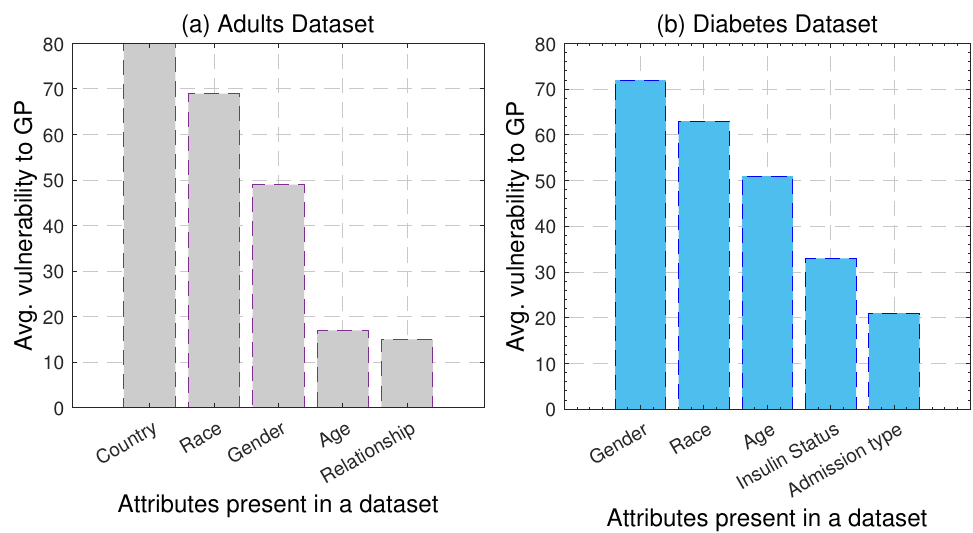
Figure 14. Overview of the vulnerability of group privacy in two datasets based on